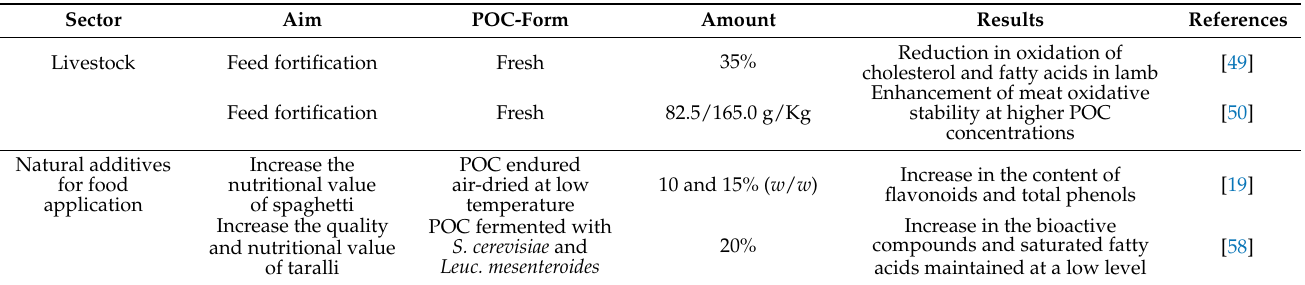
Table 2. Different applications of